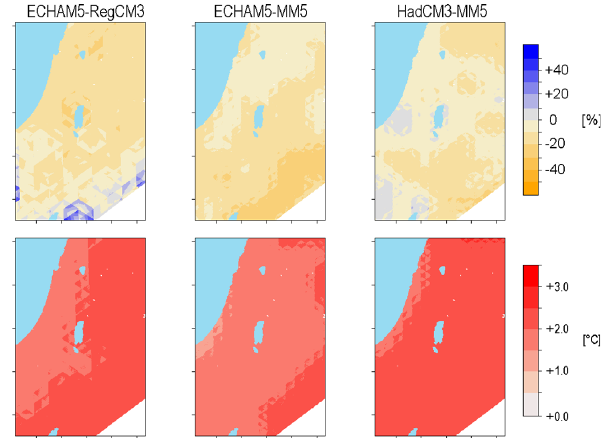
Fig. 6. Projected relative changes in annual precipitation (upper row) and annual mean temperature (lower row) simulated by three climate models. The figure shows projected data for 2031–2060 in comparison with the climate model control run